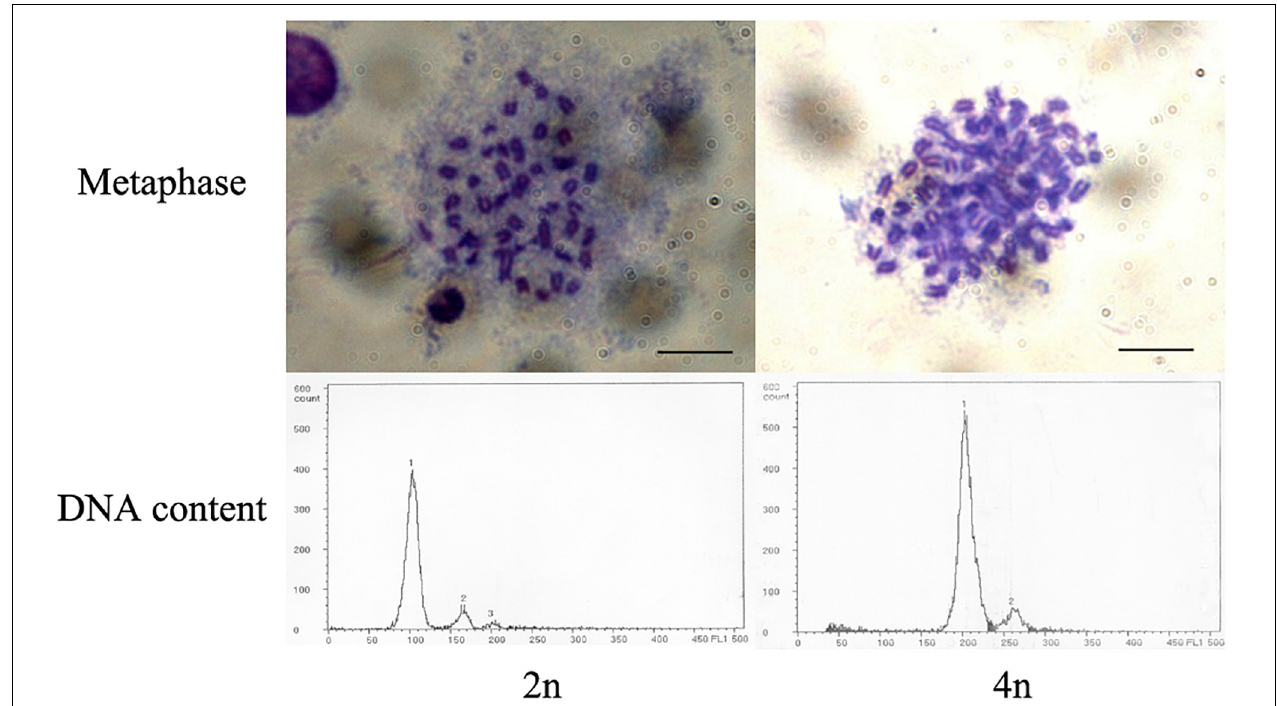
FIGURE 2 | The polyploid determination by chromosome preparation (above) and FCM (below).